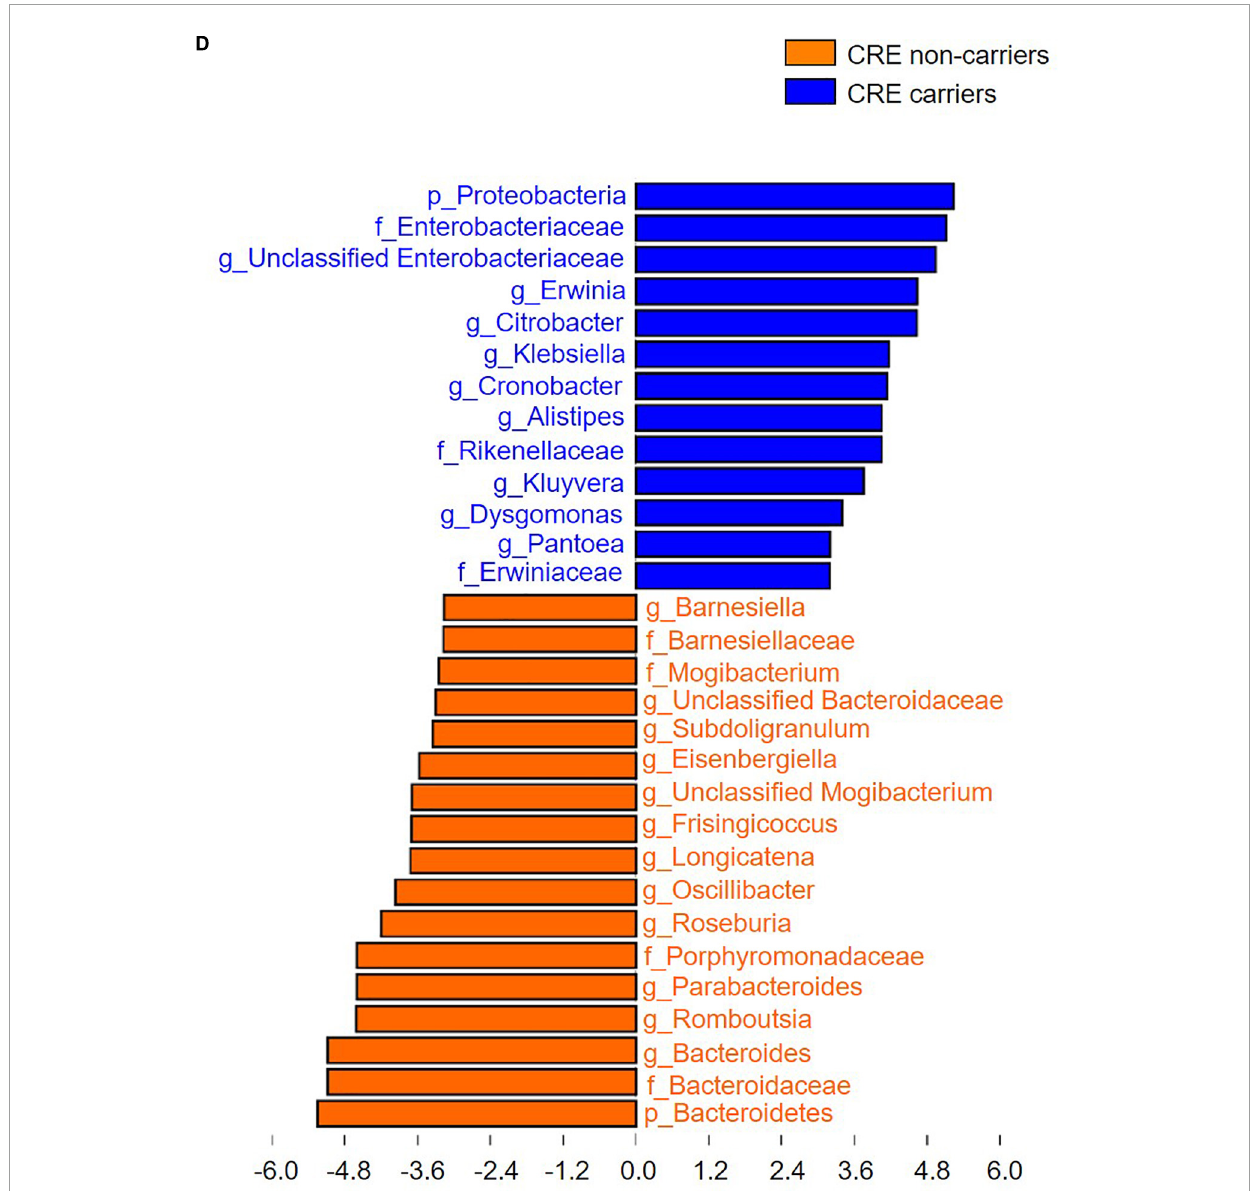
FIGURE1 Carbapenem-resistant Enterobacteriaceae (CRE) influences gut microbiota composition and community structure. (A) Microbiota composition of feces from CRE non-carriers or carriers at the phylum level. (B) Relative abundance of the phyla, Proteobacteria, Bacteroidetes, and Firmicutes. (C) Taxonomic cladogram from linear discriminant effect size (LEfSe) analysis. Dot size is proportional to taxon abundance. (D) Linear discriminant analysis (LDA) scores obtained from LEfSe analysis of fecal microbiome. An LDA effect size of more than 2 was used as a threshold for the